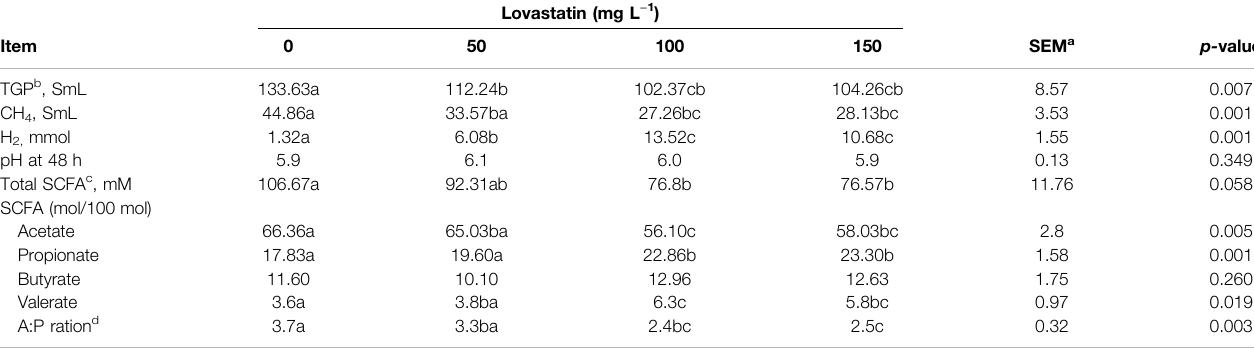
TABLE 2 | Effects of fermented oat straw as a lovastatin-carrier additive on total gas production, methane, and short-chain fatty